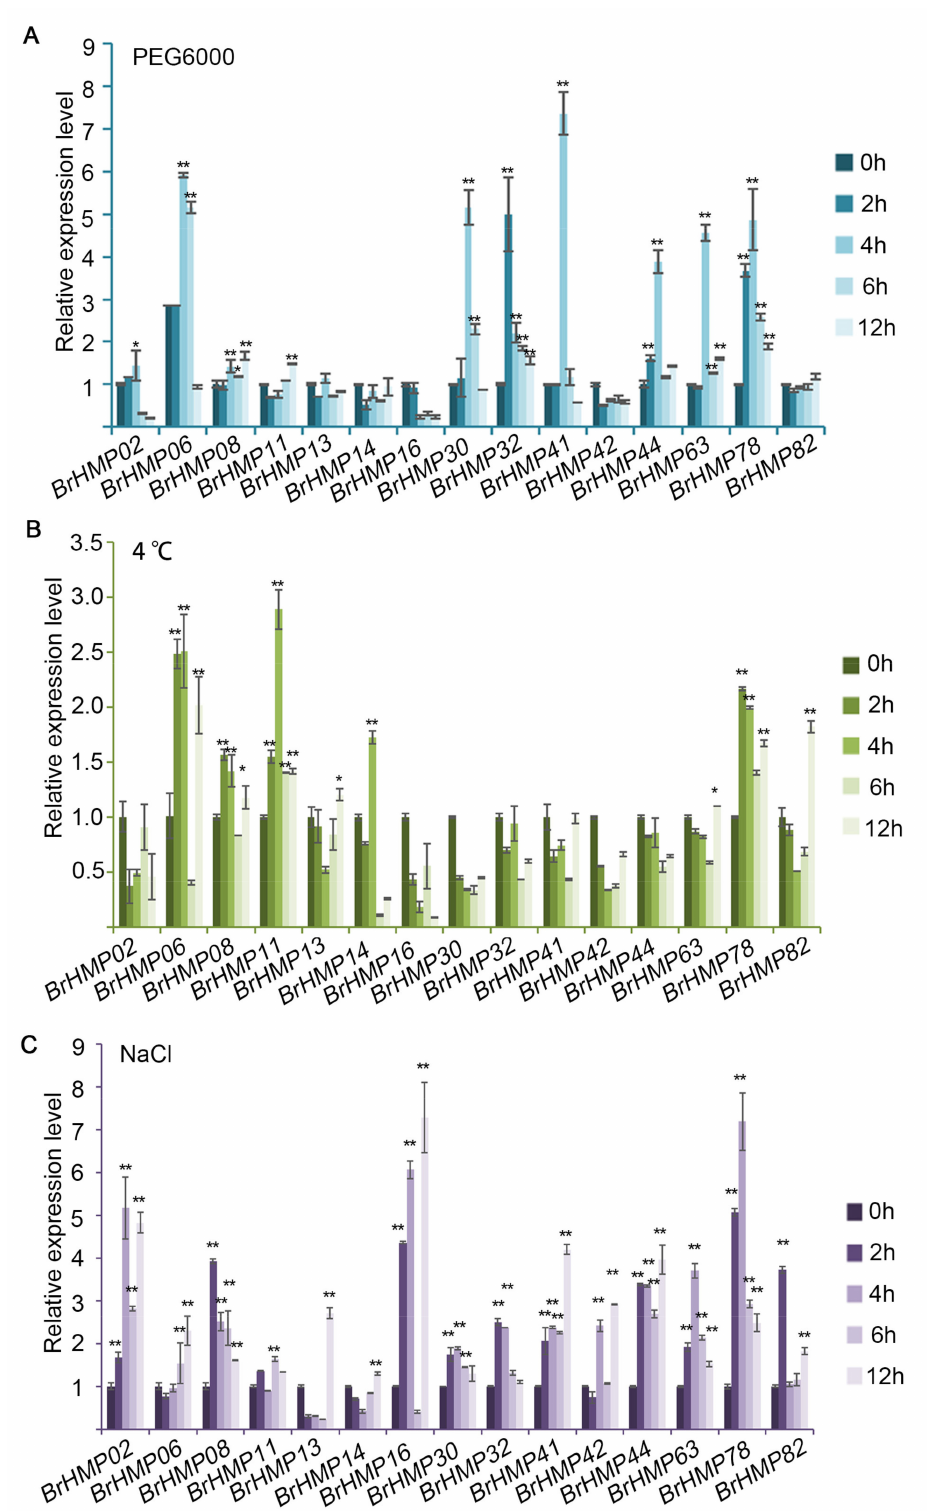
Figure 9. Analysis of the expression of 15 BrHMP genes in response to abiotic stress by qRT-PCR. ( A ) PEG6000 was used to simulate drought stress; ( B ) 4 ◦ C was used to simulate cold stress; ( C ) NaCl was used to simulate salt stress. The experiment above was controlled with 0 h, and samples were tested after 2 h, 4 h, 6 h, and 12 h. The data are shown as mean ( ± SD), Student t test, * p < 0.05, ** p <